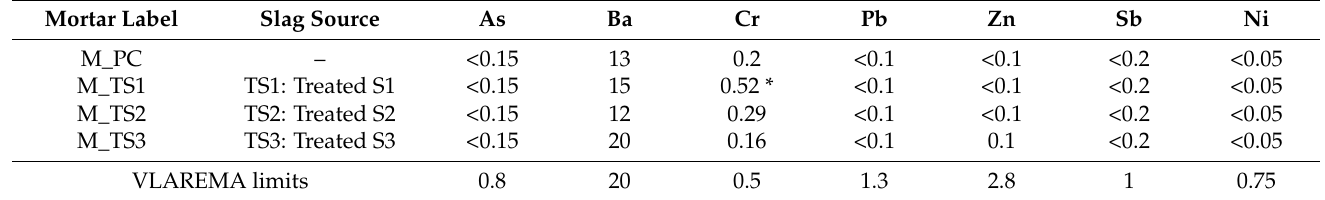
Table 11. The batch-leaching test result of the crushed mortar mixtures: metal content is expressed in mg/kg dry-mass basis. Mortar